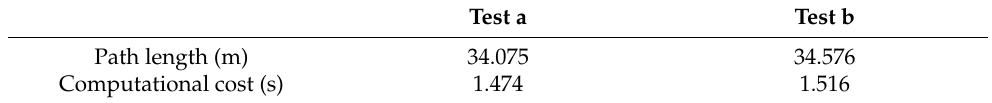
Figure 13. Path-following simulation with multi static obstacles: ( a ) round obstacles; and ( b ) rec- tangular obstacles. Table 2. The computational cost and path length in the simulations with multi static obstacles. Test a